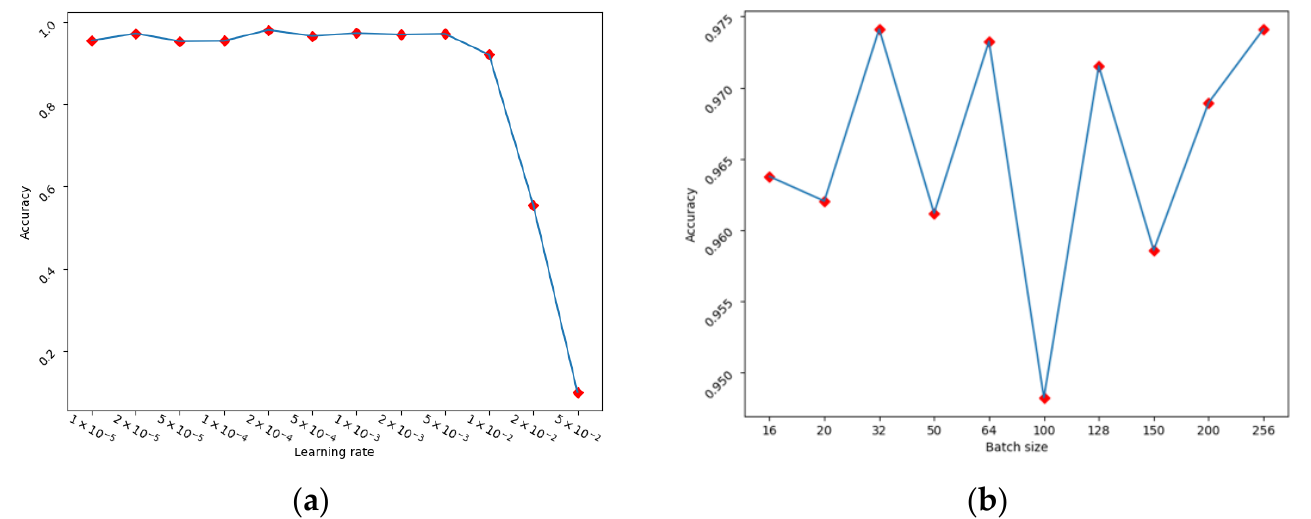
Figure 4. Model accuracy on various learning rates ( a ) and batch sizes ( b ), shown as the red square. Table 2. Training hyperparameters.